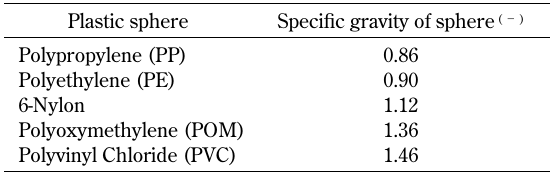
Table 2 Specific gravity of plastic sphere employed Plastic